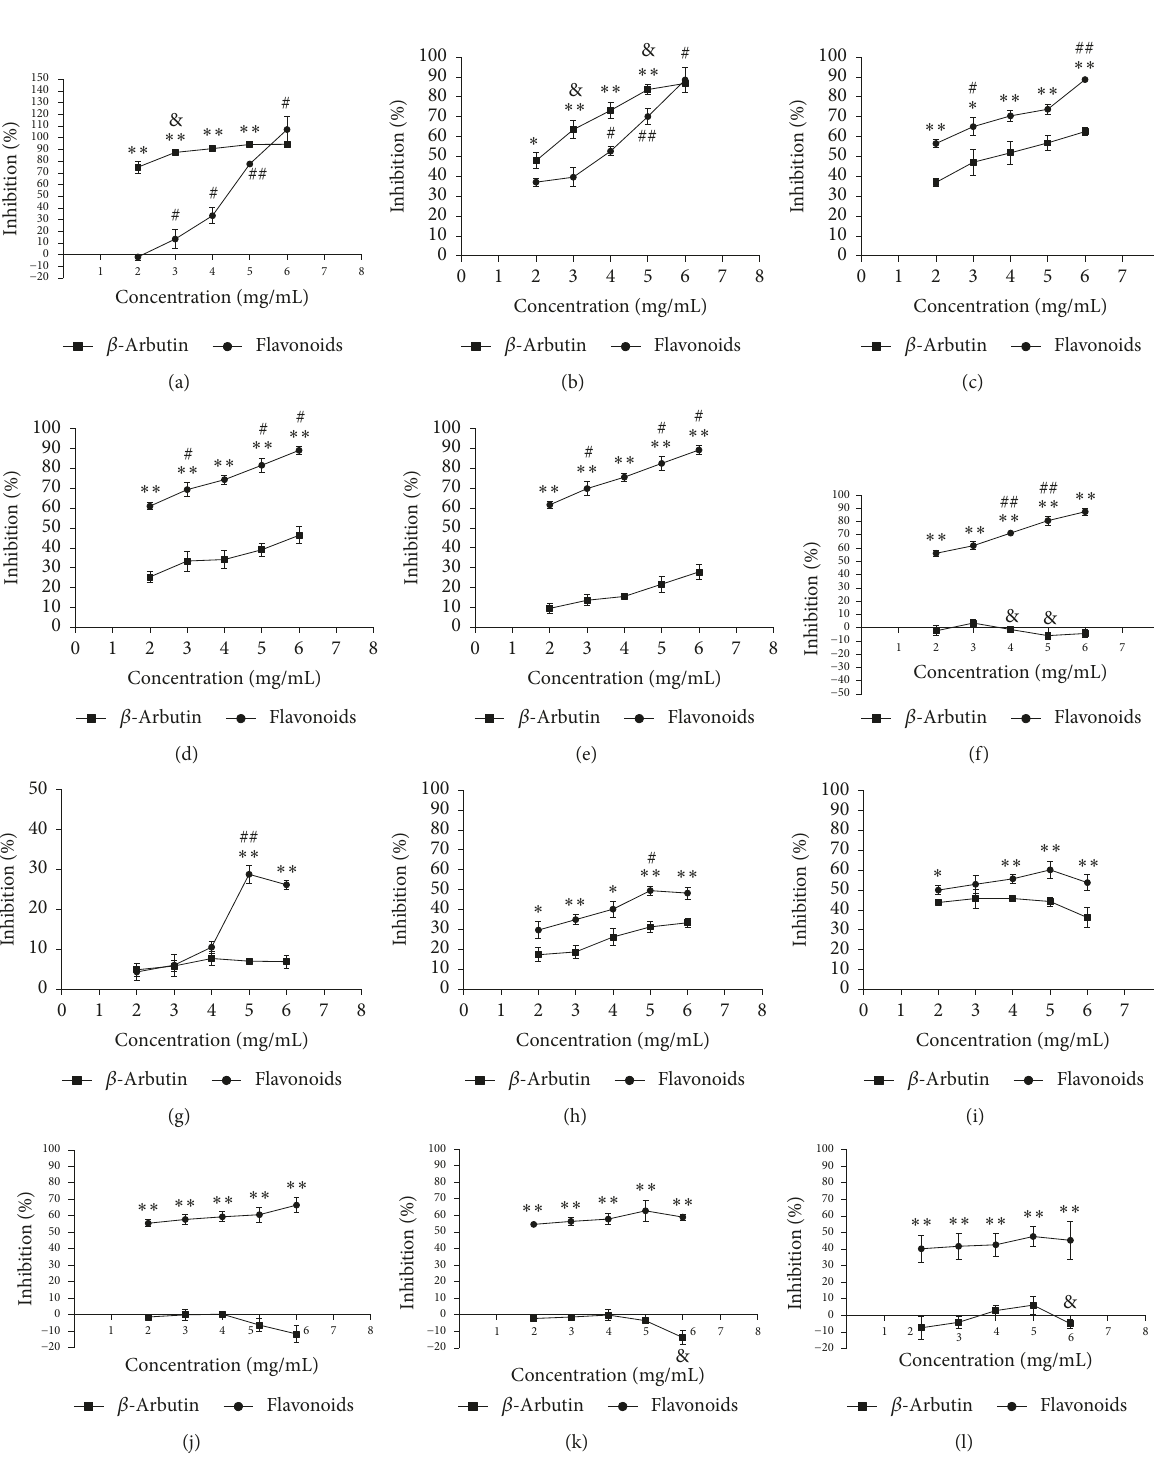
Figure 3: (a)–(f) Monophenolase activity inhibition rates at 10, 30, 60, 90, 120, and 240 min, respectively. (g)–(l) Diphenolase activity inhibition rates at 10, 30, 60, 90, 120, and 240 min, respectively. ∗∗ P < 0.01 versus 𝛽 -arbutin, ∗ P < 0.05 versus 𝛽 -arbutin, ## P < 0.01, # P < 0.05 self-comparison of flavonoids, && P < 0.01, & P < 0.05 self-comparison of 𝛽